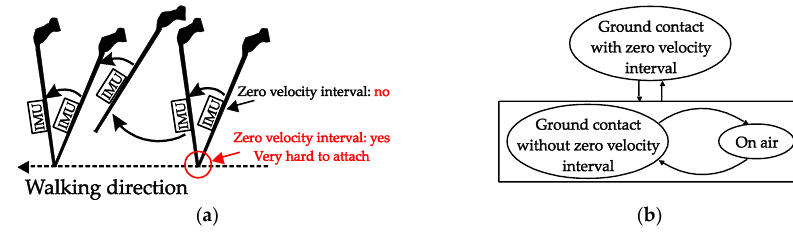
Figure 7. Standard cane movement: ( a ) Visualization; ( b ) State diagram.